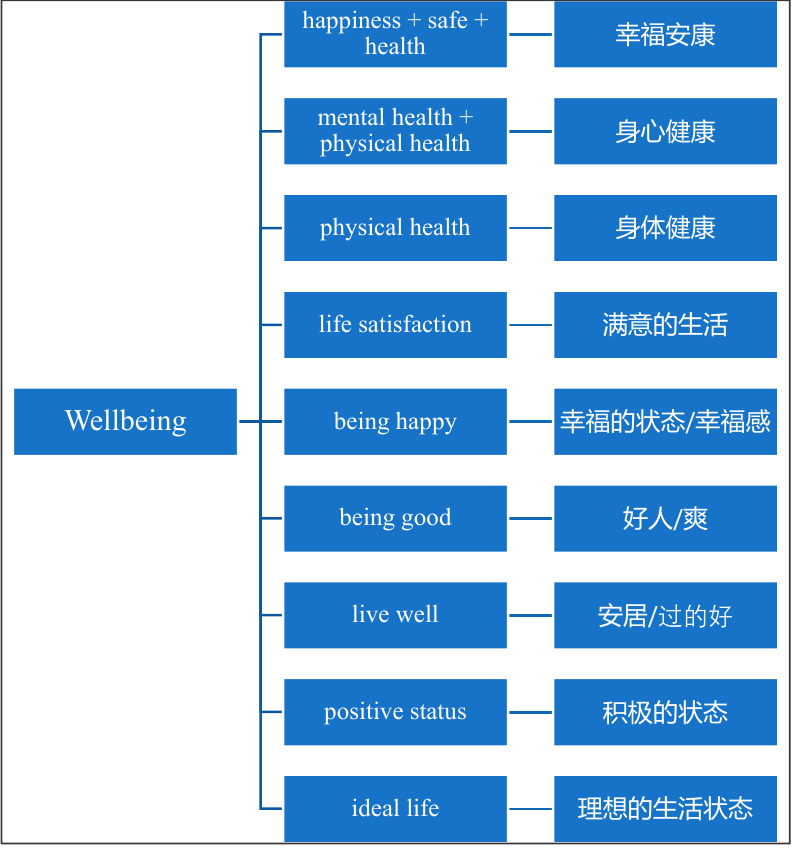
Figure 3. Participants’ Chinese translations of the word “wellbeing”.